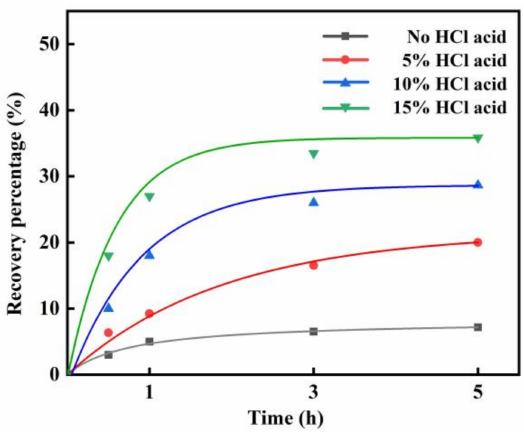
Figure 4. Recovery extent of oxalic acid at various HCl adding